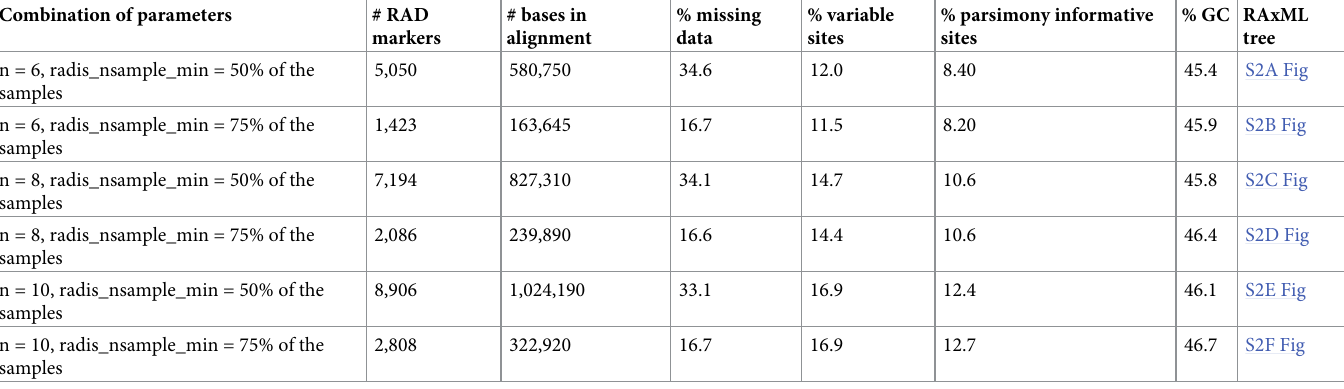
Table 2. Properties of the RAD data sets obtained with different parameters combinations. n = number of mismatches allowed when merging individual loci in cstacks, radis_nsample_min = minimum number of samples that should have sequences for a RAD locus to be included in the analysis. In all data sets, loci for which at least one sample had three or more sequences ( i . e . possible paralogs) were removed (radis_npbloci_cutoff = 3). Combination of parameters # RAD